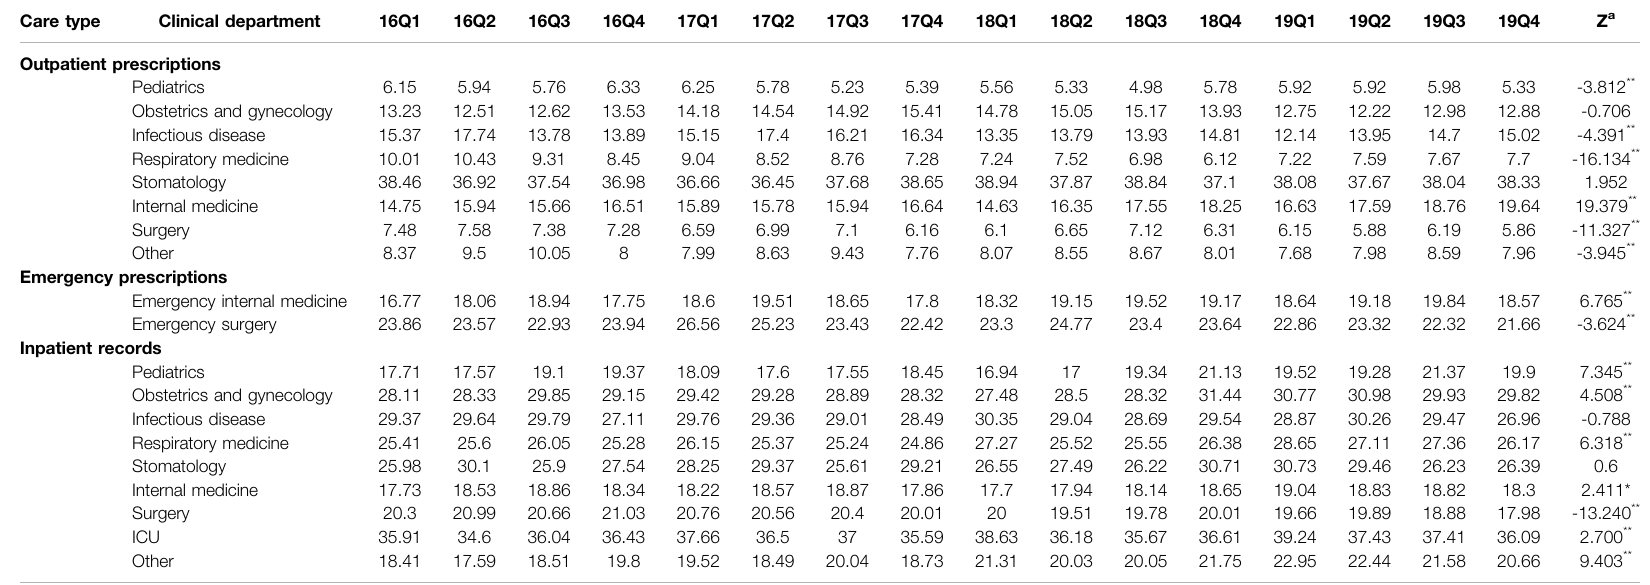
TABLE 3 | Changes in proportion of prescribed with muti-antibiotics in different clinical departments, 2016 – 19. Care type